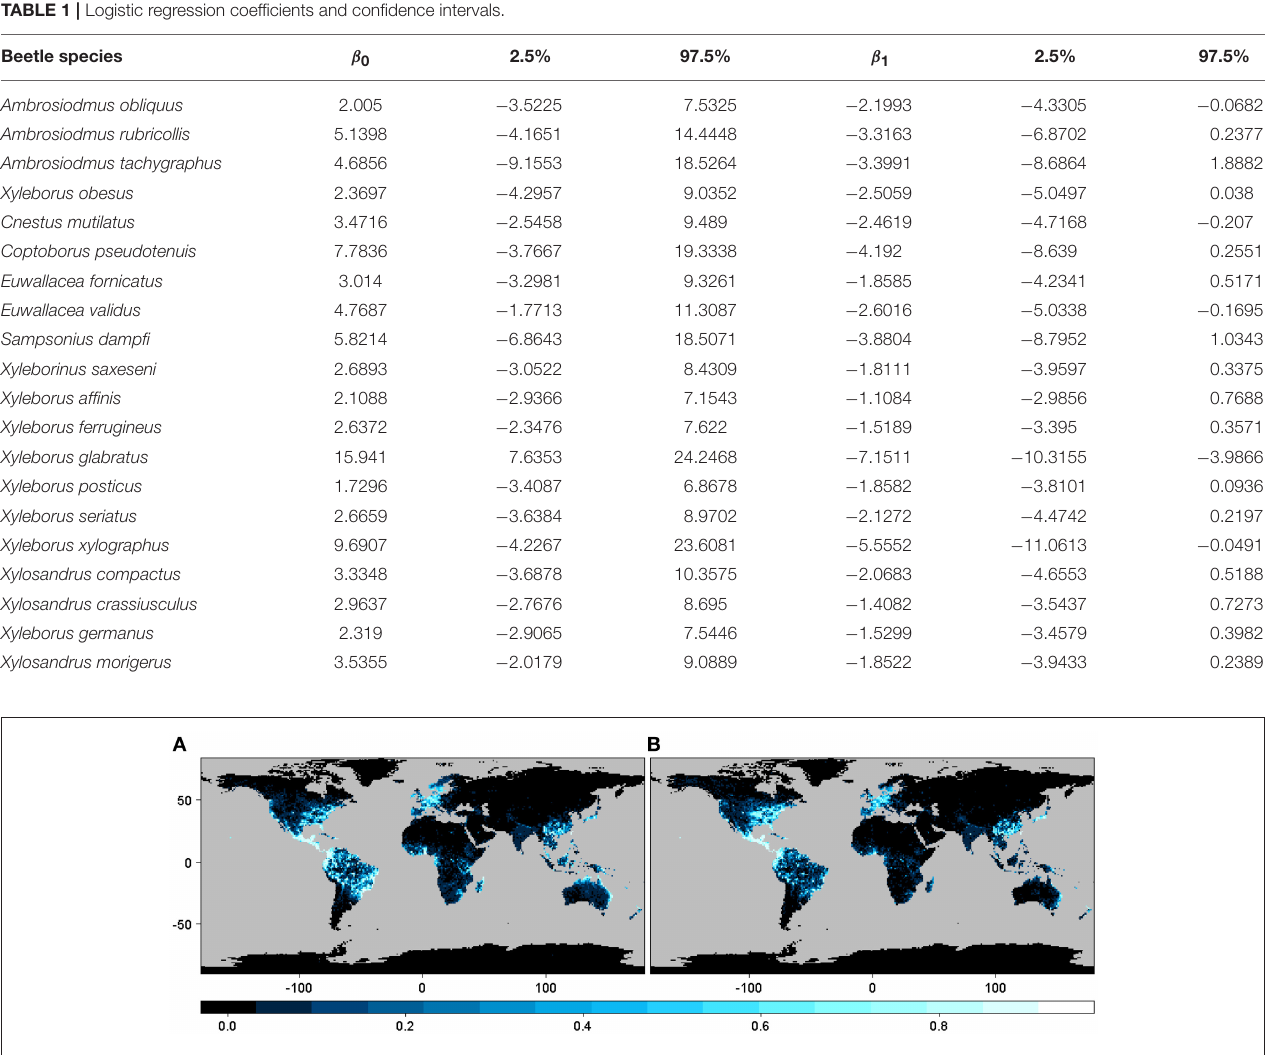
FIGURE 2 | Spatial projection of the interaction or infection index summarized at 1-degree spatial resolution for the case with all of the beetles pooled together using GBIF occurrence information from (A) host plant genera derived from the list of host plant species in the bark beetles database (M 1 ) and (B) host plant genera in the phylogenetic tree after obtaining the occurrences for each genus directly using the R package spocc (M 2